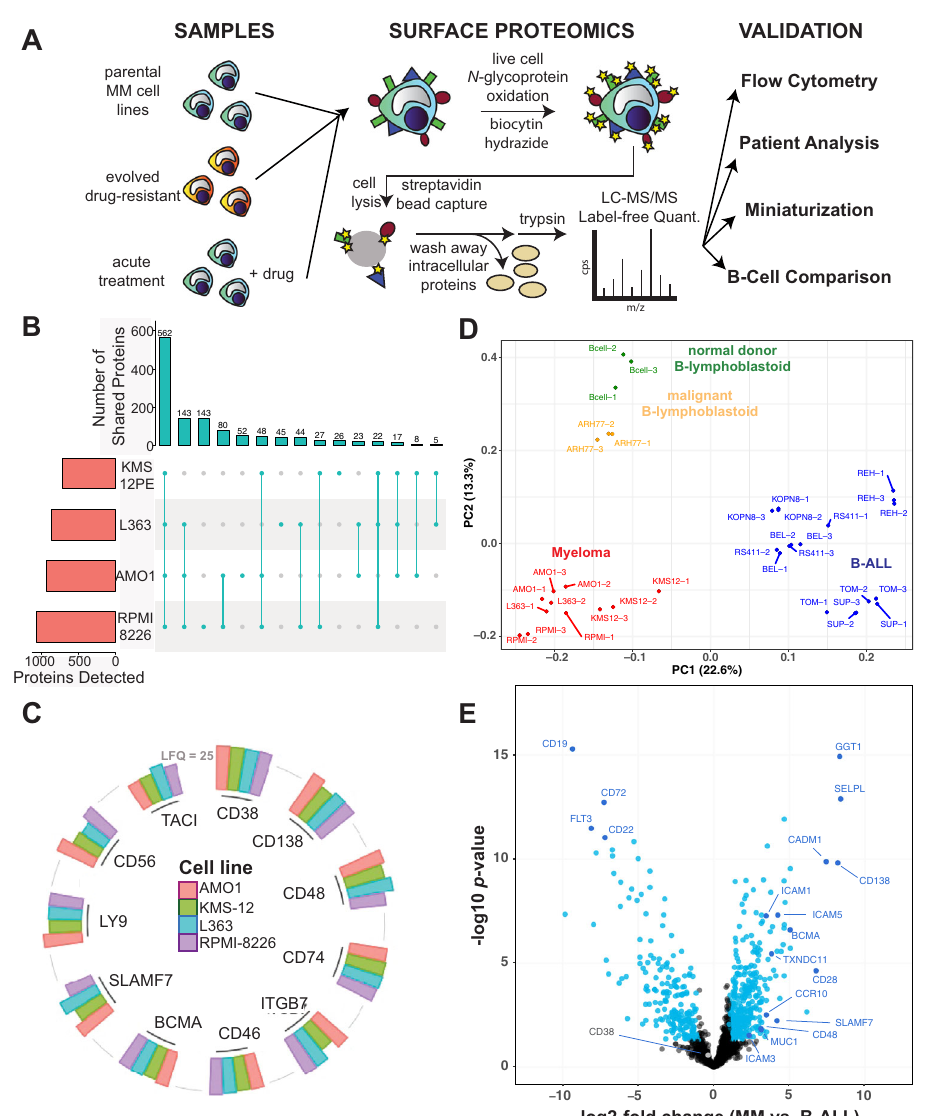
Fig. 1 Initial elucidation of the myeloma plasma cell surfaceome. A Overall schematic of surface proteomic investigations in this study. This includes a description of the modi fi ed cell surface capture (CSC) methodology used, with biotinylated proteins identi fi ed after on-bead trypsinization. B Upset plot shows high degree of overlap in identi fi ed glycoproteins, fi ltered for annotated membrane proteins, across the four evaluated myeloma cell lines. Data included if identi fi ed with two peptides in at least one of three biological replicates per cell line. C Common myeloma diagnostic markers and immunotherapeutic targets were identi fi ed by cell surface proteomics in all four evaluated cell lines. Height of column indicates label-free quanti fi cation (LFQ) intensity from MaxQuant, averaged across biological replicate samples (AMO1: n = 3, L363: n = 2, KMS12: n = 3, RPMI-8226: n = 3). A threshold of LFQ = 25 is indicated by gray line. D Principal component analysis (PCA) illustrates the differential cell surface landscape of myeloma cells versus B-lymphoblastoid cells and B-cell acute lymphoblastic leukemia cell lines. E Volcano plot comparing glycoprotein LFQ intensity of four myeloma cell lines (replicate information listed above for C ) to eight B-ALL cell lines ( n = 3 biological replicates each). Signi fi cantly changed proteins colored in blue (log 2 -fold change > |1 | ; p < 0.05 by t -test). For B – E , source data in Supplementary Data